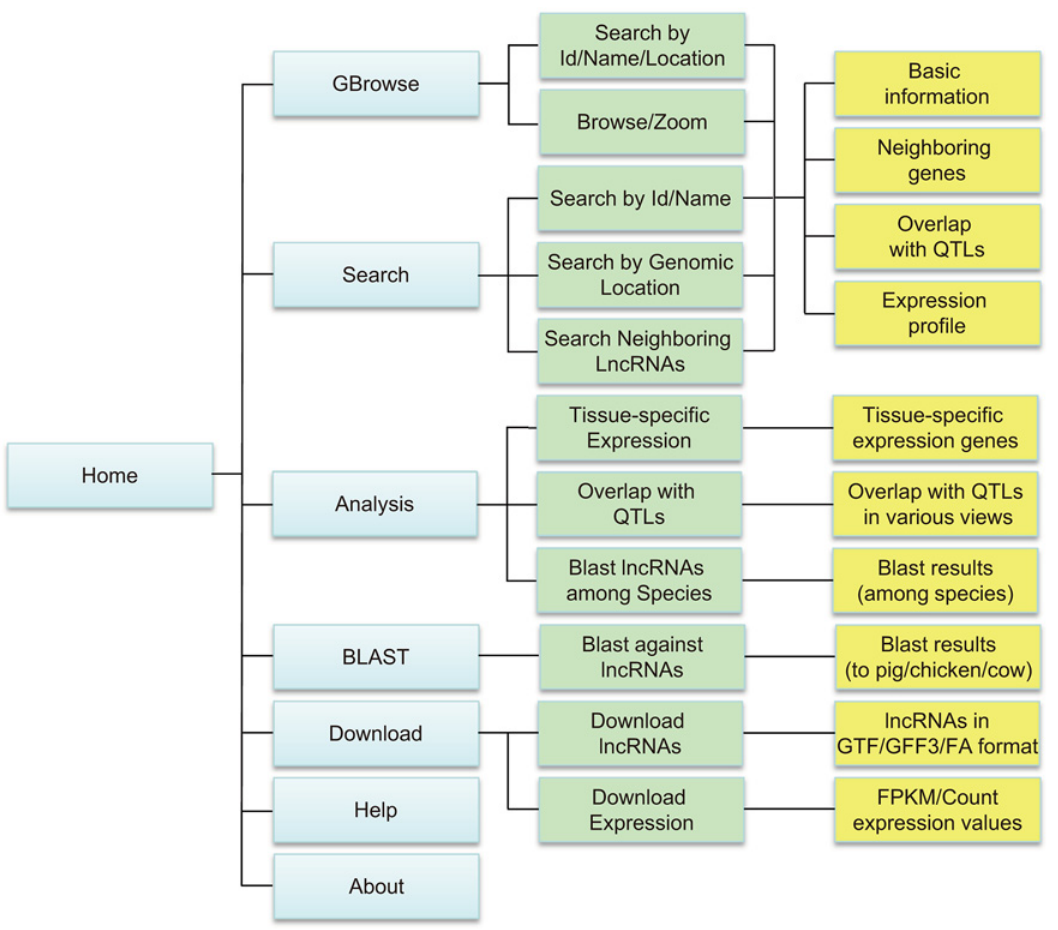
Fig 2. Schematic illustration of ALDB sitemap. Blue box: navigation bar. Green box: processing. Orange box: outcomes.